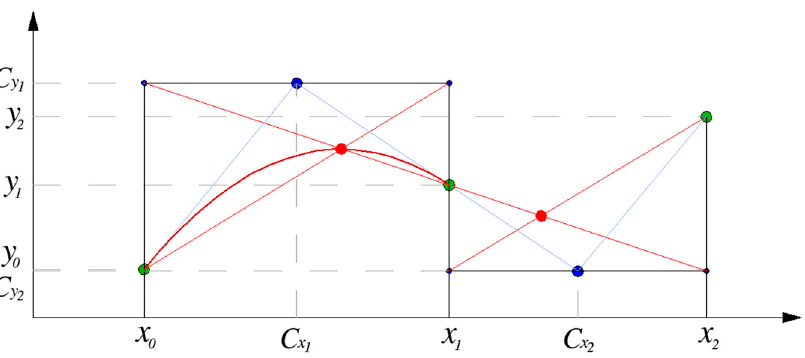
Figure 11. Line segment x y . The extrema of the parabolas are marked with a red dot, the control points with a blue dot, and the green dots indicate points to be interpolated.